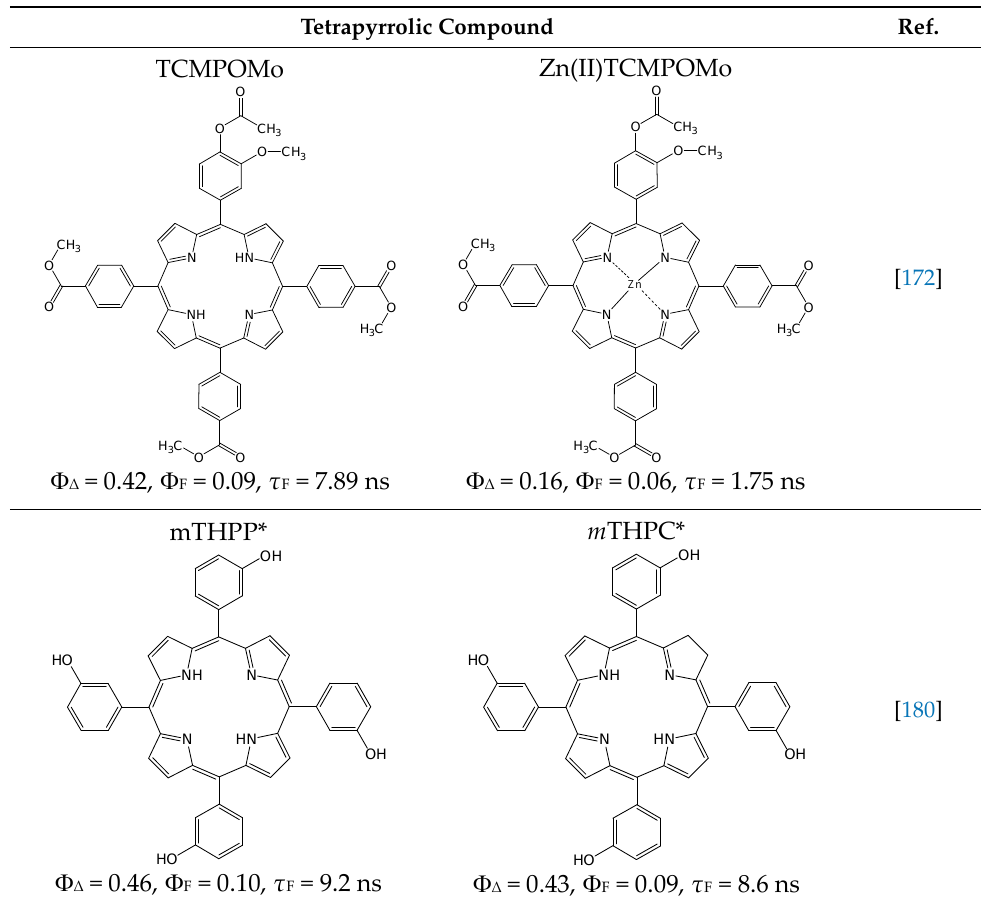
Table 3. Cont . Tetrapyrrolic Compound